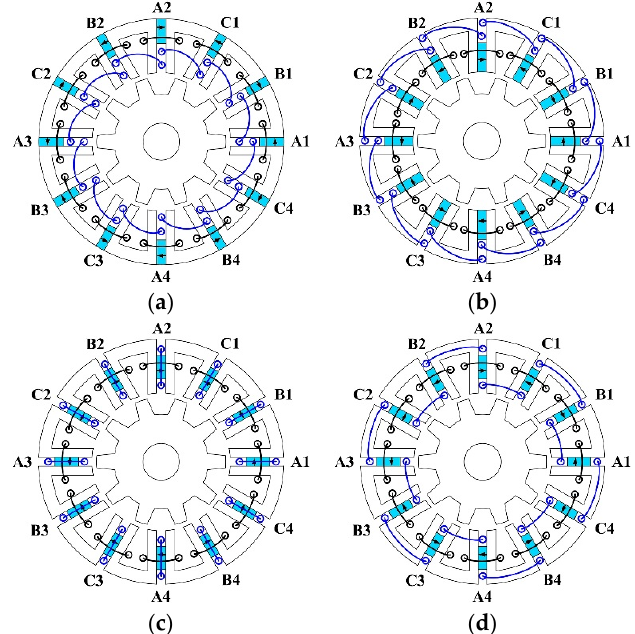
Figure 1. Cross sections of the 12 ‐ stator ‐ slots/10 ‐ rotor ‐ poles HEFS machines. ( a ) PM ‐ top; ( b ) PM ‐ bottom; ( c ) PM ‐ middle ‐ 1; ( d ) PM ‐ middle ‐ 2.